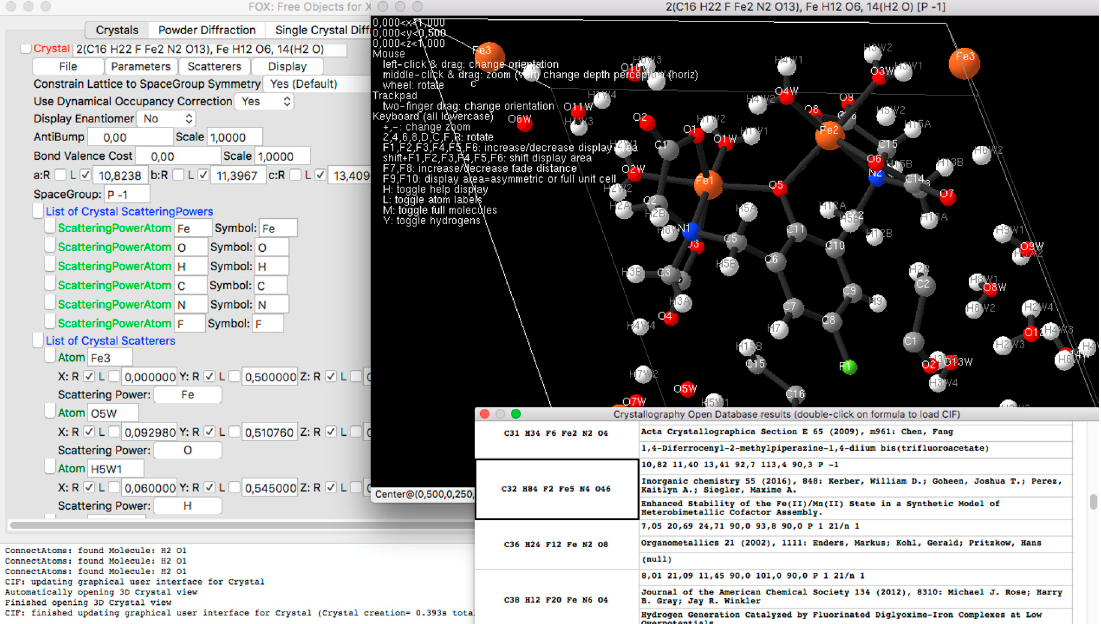
Figure 3. Main FOX interface. Left: main window with the beginning of the description of a crystal structure. Top right: 3D view of the structure, with the help text, showing only the asymmetric unit. Several shortcuts are available to easily toggle between different views (full unit cell, toggle hydrogens, fade atoms outside display volume…). Bottom right: result of querying the Crystallography Open Database [30], after searching for structures with elements C, N, O, F, Fe and 6 different elements. A simple double-click allows to load the CIF in FOX, where the molecules are automatically built by analysing the atomic distances.